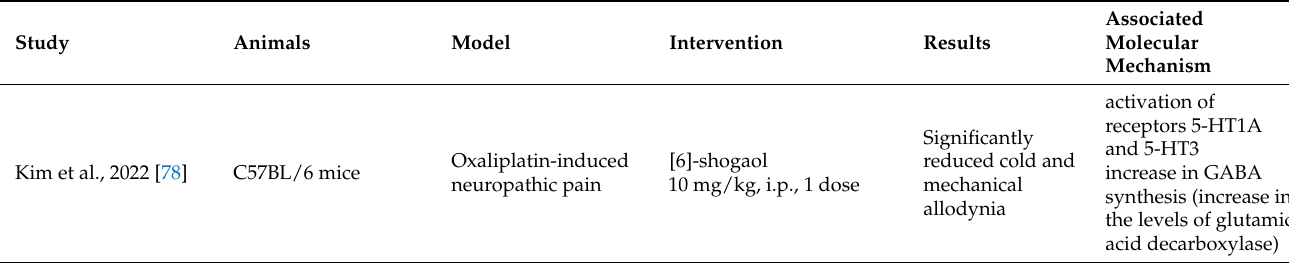
Table 2. In vivo studies on the effect of ginger extract and its components. Associated molecular